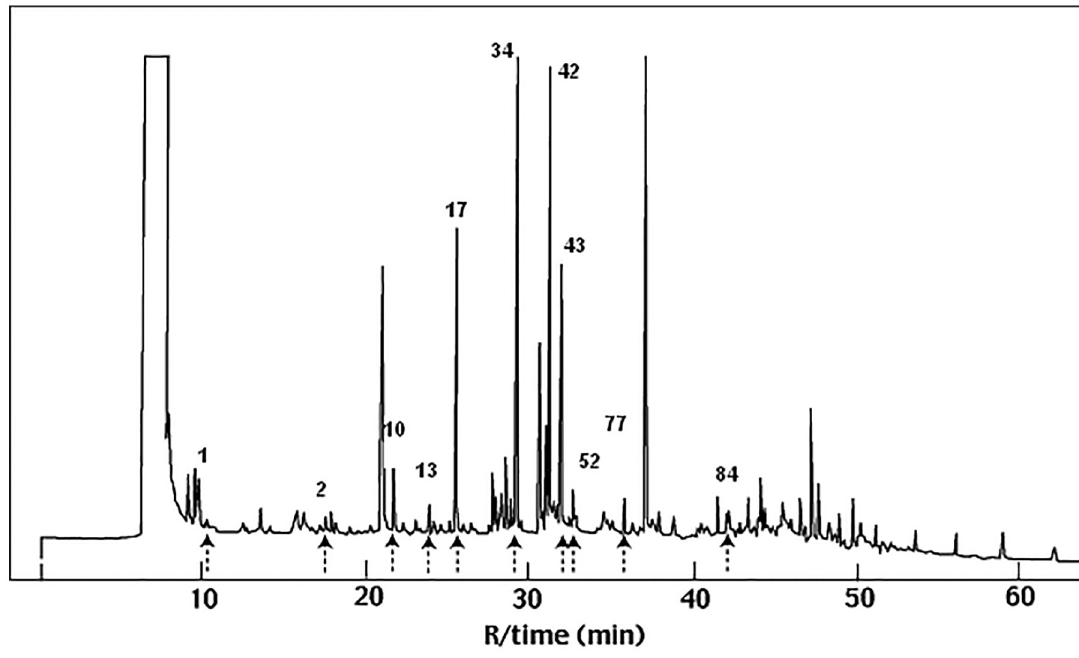
Fig 3. The GC-FID profile with the EAD-active components (numbered) of the most attractive human foot odor.